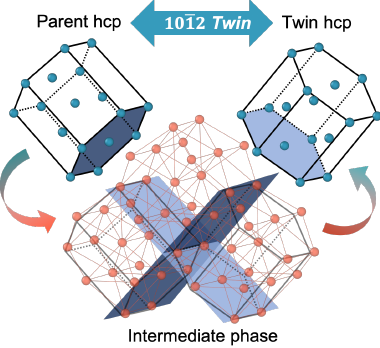
Figure 3. Orientation relation of the parent hcp phase, metastable tetragonal phase, and twinned hcp phase. Dark blue represents the parent basal plane and tetragonal (100) plane, and light blue represents the twin basal plane and tetragonal (010) plane. The black lines in the intermediate phase are drawn to show the correspondence between the parent hcp, intermediate, and twin hcp phases.